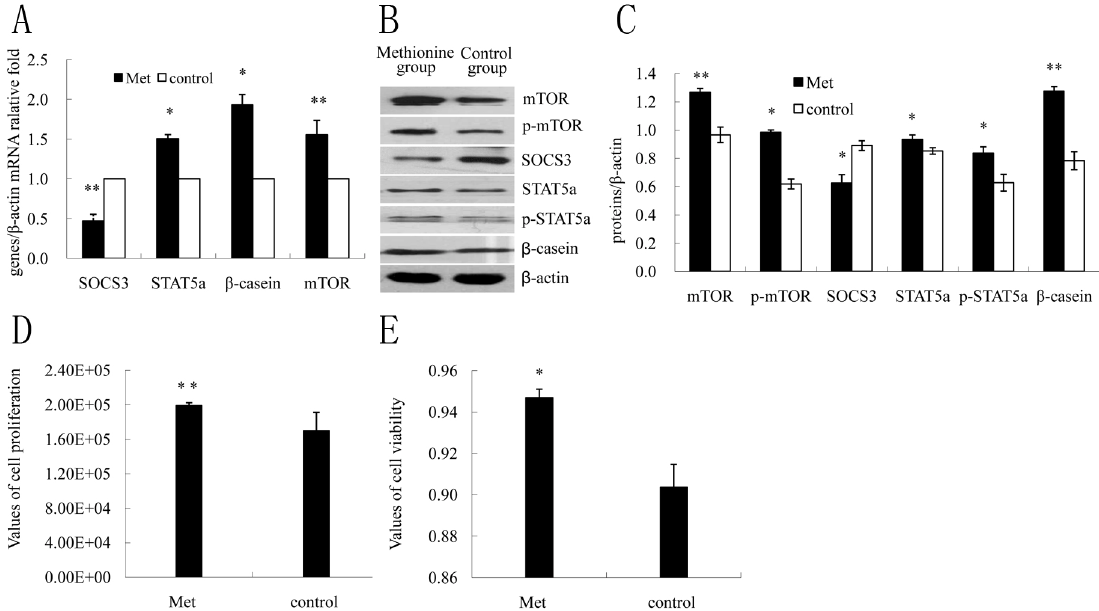
Figure 4. Effect of Met on SOCS3 to regulate β -casein expression and cell proliferation in DCMECs. DCMECs were treated with Met (0.6 mmol L − 1 ) for 24 h, not treated (control). ( A ) Changes of mRNA levels of key genes on milk protein synthesis were detected by qRT-PCR; ( B ) Western blotting results of SOCS3, STAT5a, p-STAT5a, mTOR, p-mTOR, β -casein and β -actin at 24 h after treatment with Met; ( C ) Results of gray scale scan of SOCS3, STAT5a, p-STAT5a, mTOR, p-mTOR, β -casein/ β -actin relative fold by western blotting after treatment with Met; ( D , E ) Cell proliferation and viability were determined by the CASY assay. Different superscripts denote signi fi cant differences relative to